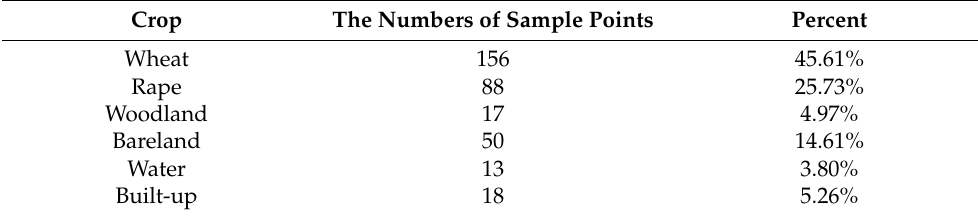
Figure 3. The spatial distribution of visual interpretation samples in Huaibin County. Table 3. The number of visual interpretation sample points.